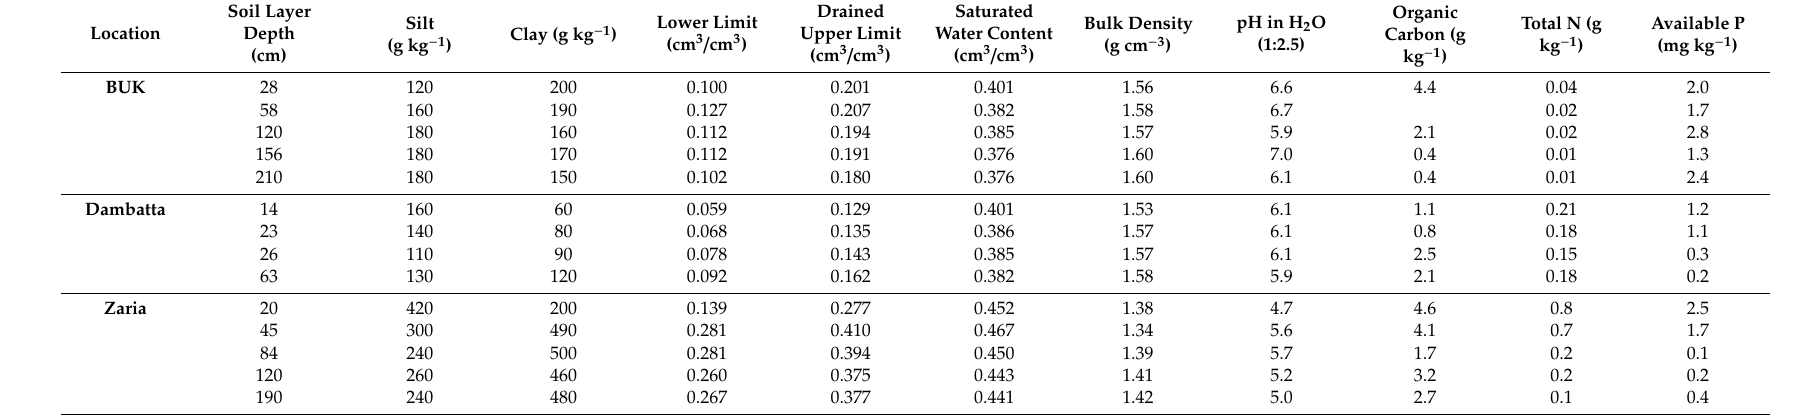
Table 1. Soil properties used for calibration experiments at BUK, Dambatta, and